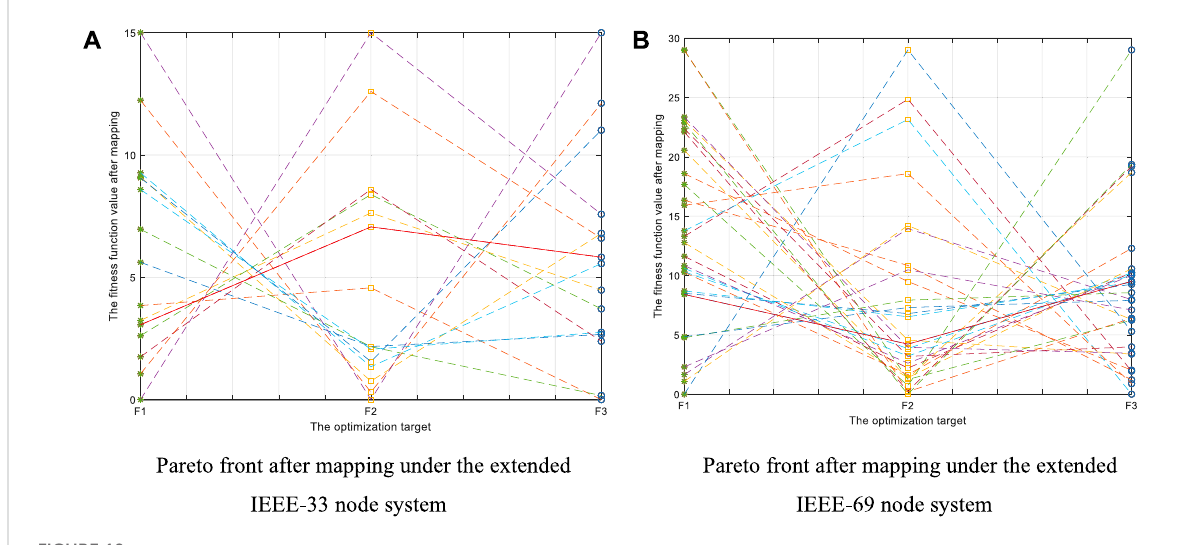
FIGURE 10 ThePareto frontoftheparallelcoordinatesystemundertheextended IEEE-33nodesystem andtheextendedIEEE-69nodesystem. (A) Pareto front after mapping under the extended IEEE-33 node system. (B) Pareto front after mapping under the extended IEEE-69 node